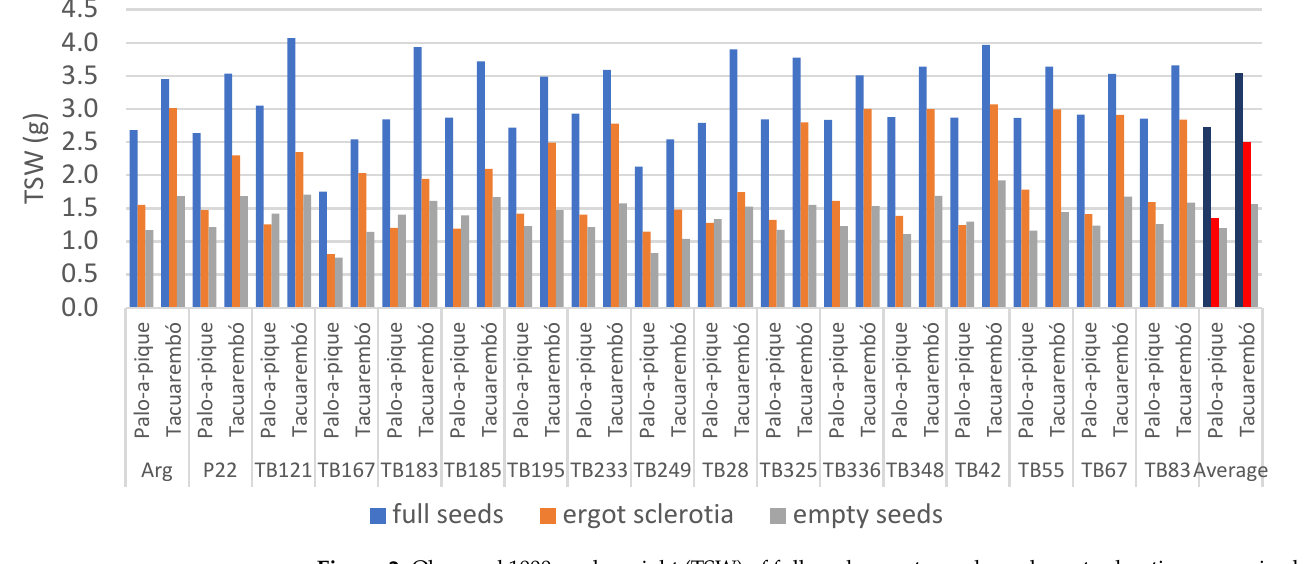
Figure 2. Observed 1000 seeds weight (TSW) of full seeds, empty seeds, and ergot-sclerotia summarized by genotype and location. Location averages represented in darker colors. The TSW of ergot-sclerotia was also affected by location and genotype, and by their interaction (Table 3), with genotypic differences at both locations ( p = 0.0074 and p < 0.0001) and with nine genotypes showing heavier ergot-sclerotia at Tacuaremb ó ( p < 0.05). On average, the TSW of ergot-sclerotia weighed 1.36 g in Palo-a-Pique and 2.50 g in Tacuaremb ó (+84%). Genotype TB249 had the lowest average weight at 1.31 g while TB336 was the heaviest at 2.31 g. The absolute minimum was registered by TB167 in Palo-a-Pique at 0.81 g, while the absolute maximum was reached by TB42 at 3.07 g in Tacuaremb ó (Figure 2). Most of the variance was explained by location, and the broad-sense heritability of this trait was estimated at 0.63 (Table